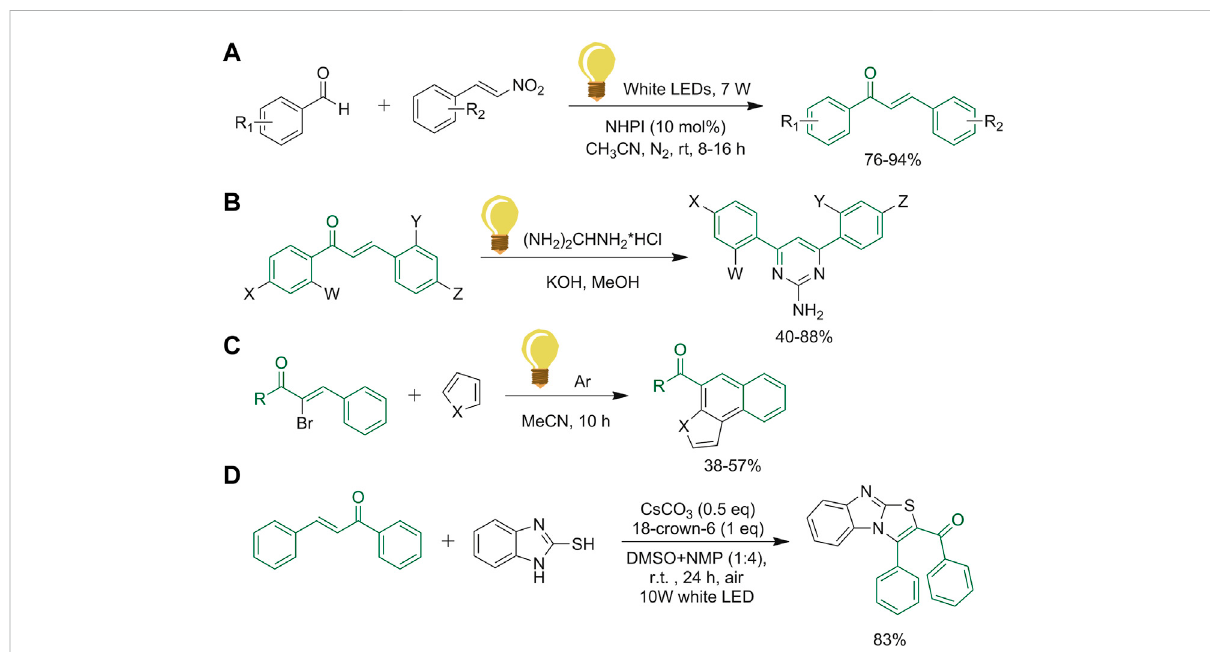
FIGURE 13 (A) Synthesis of chalcones with NHPI catalysts, an ef fi cient visible light organophotocatalyst; (B) UV-radiation reaction procedure to afford pyrimidine derivatives; (C) photo-induced tandem vinyl radical cyclization with α -bromochalcone and pyrrole derivatives; (D) visible-light